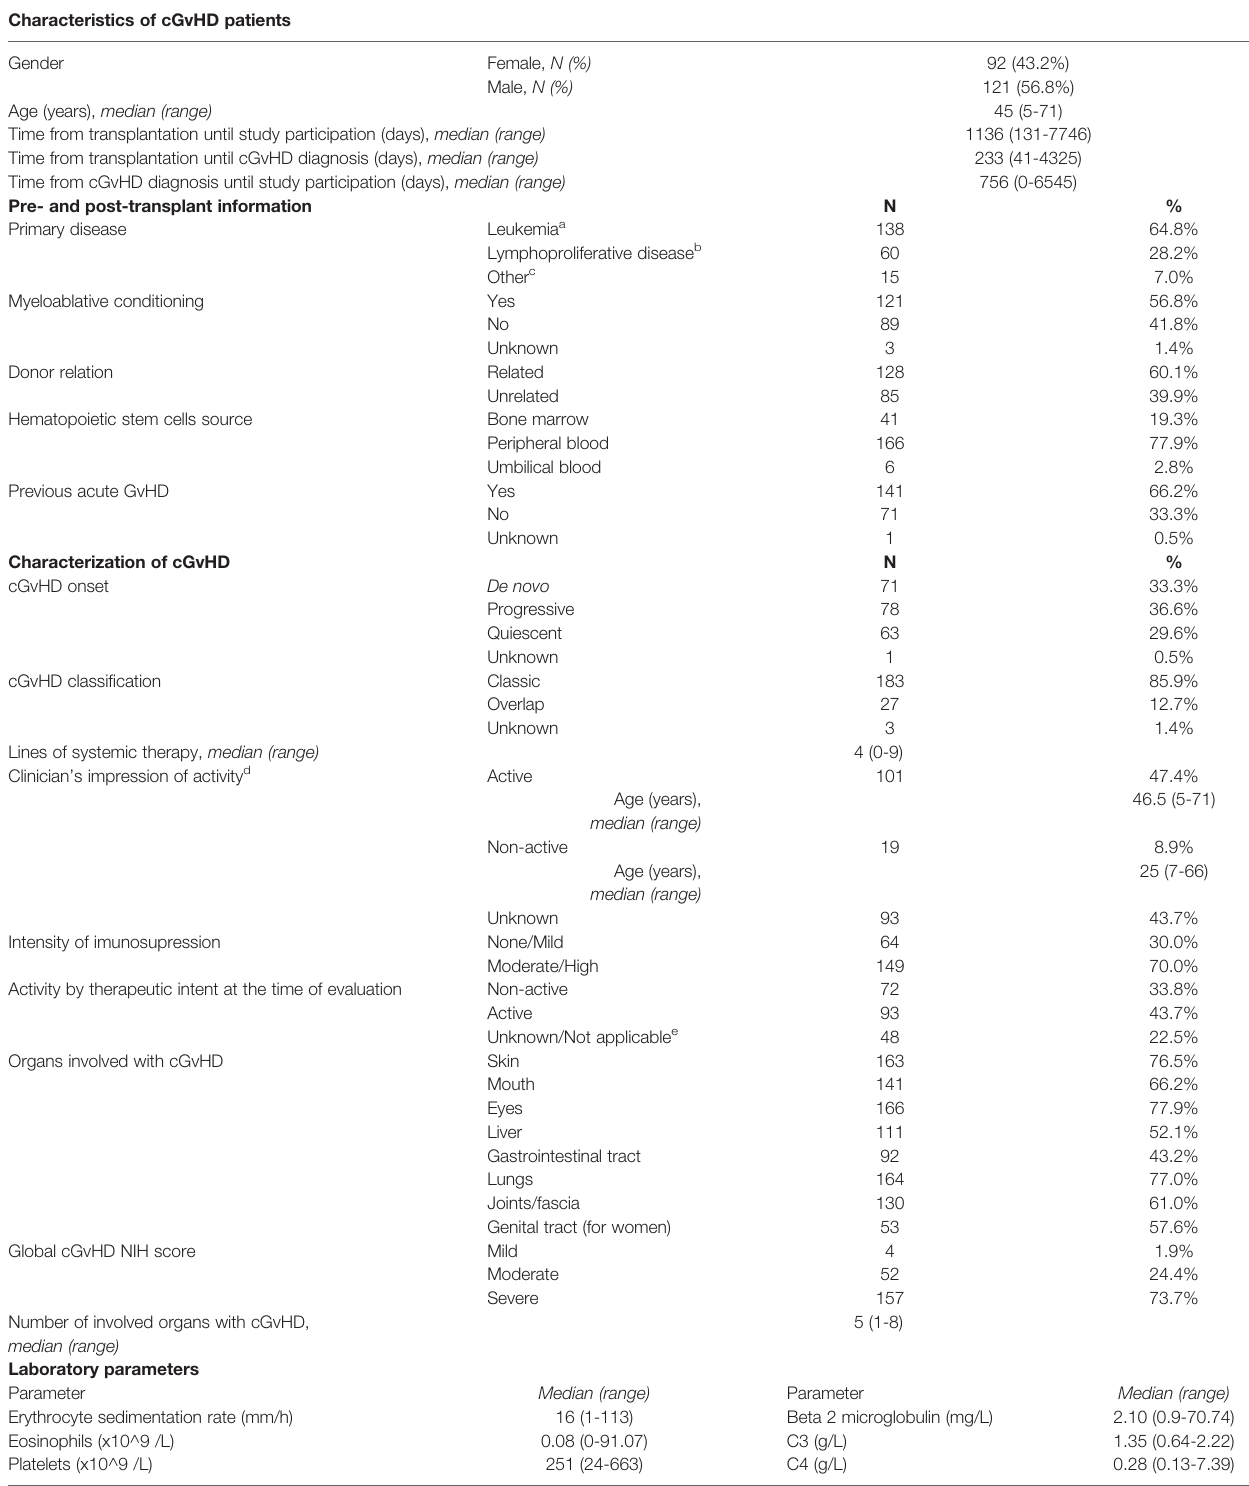
TABLE 1 | Characteristics of cGvHD patients and their clinical laboratory